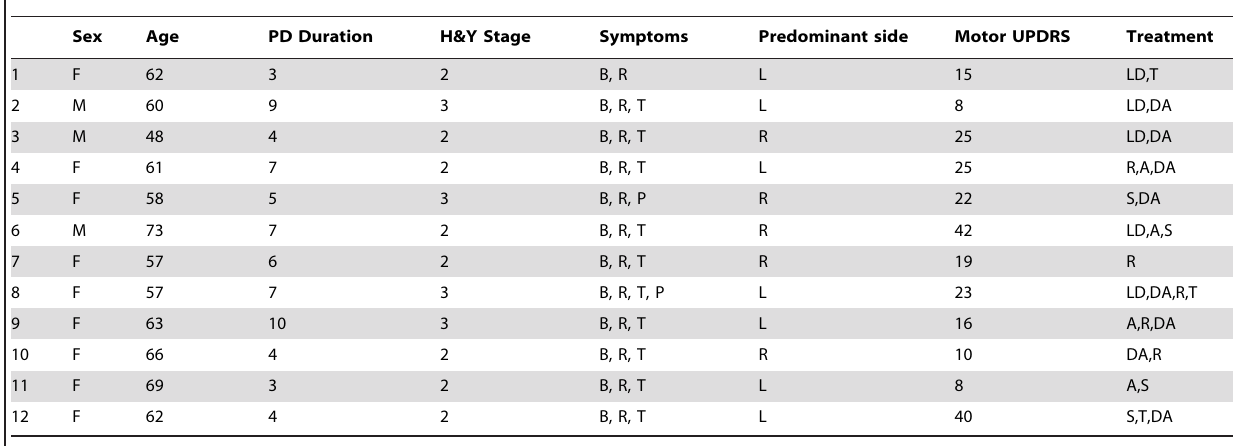
Table 2. Patient clinical